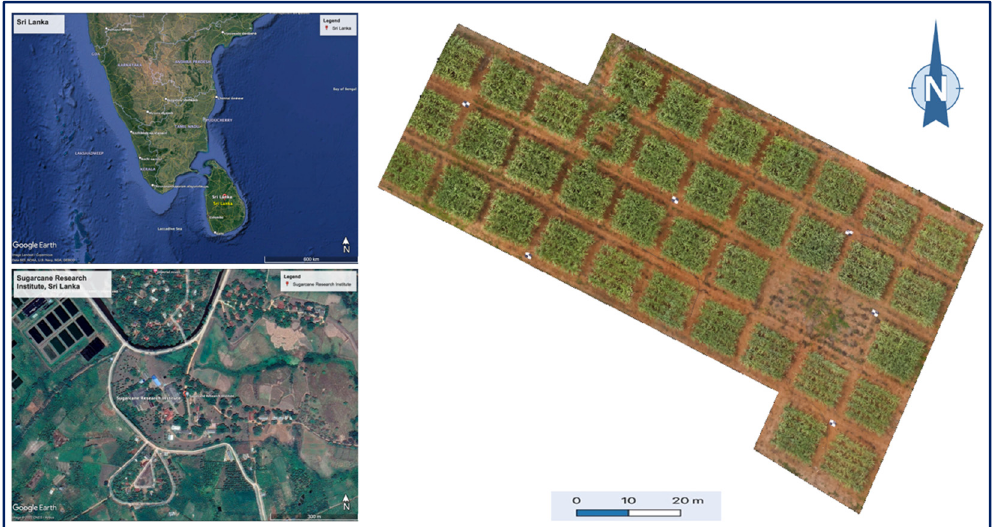
Figure 1. UAV Experimental Area at SRI.